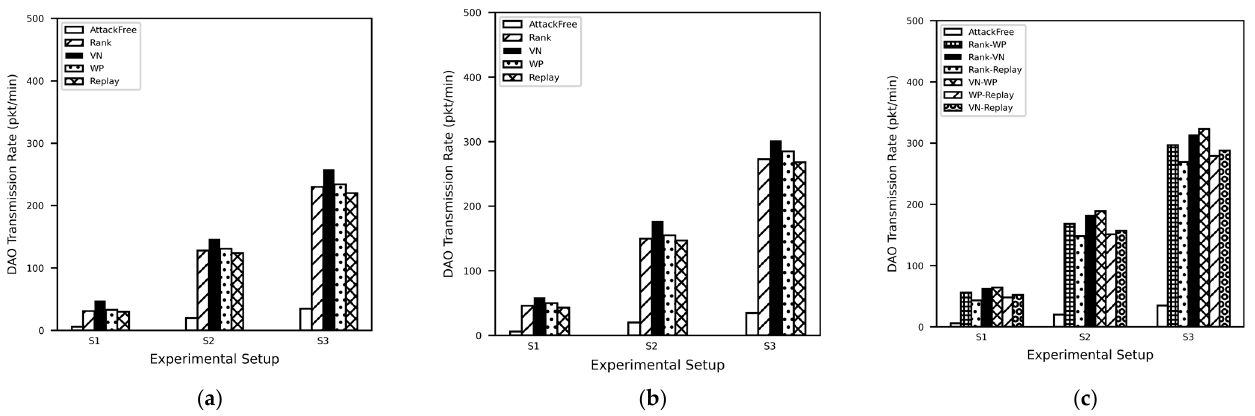
Figure 7. DAO Transmission Rate Results: ( a ) Single-Attack Scenario; ( b ) Composite-Attack Scenario; ( c ) Hybrid-Attack Scenario.